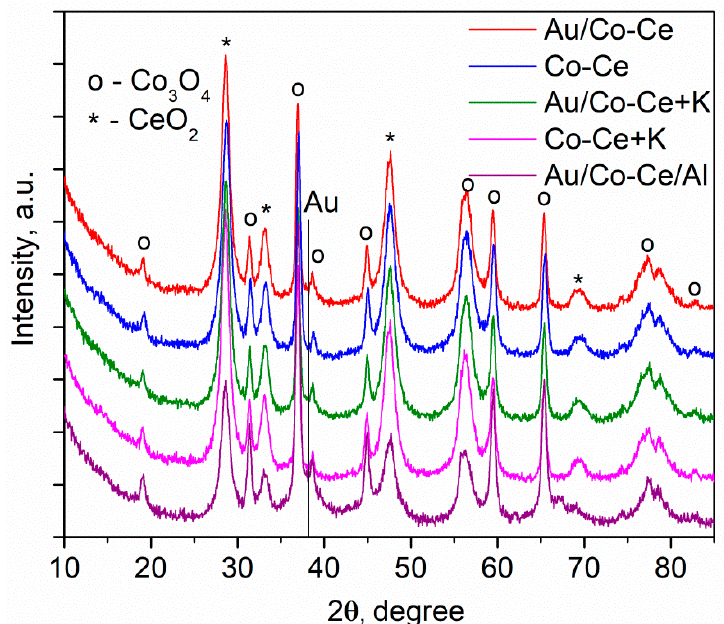
Figure 2. XRD patterns of the studied samples.